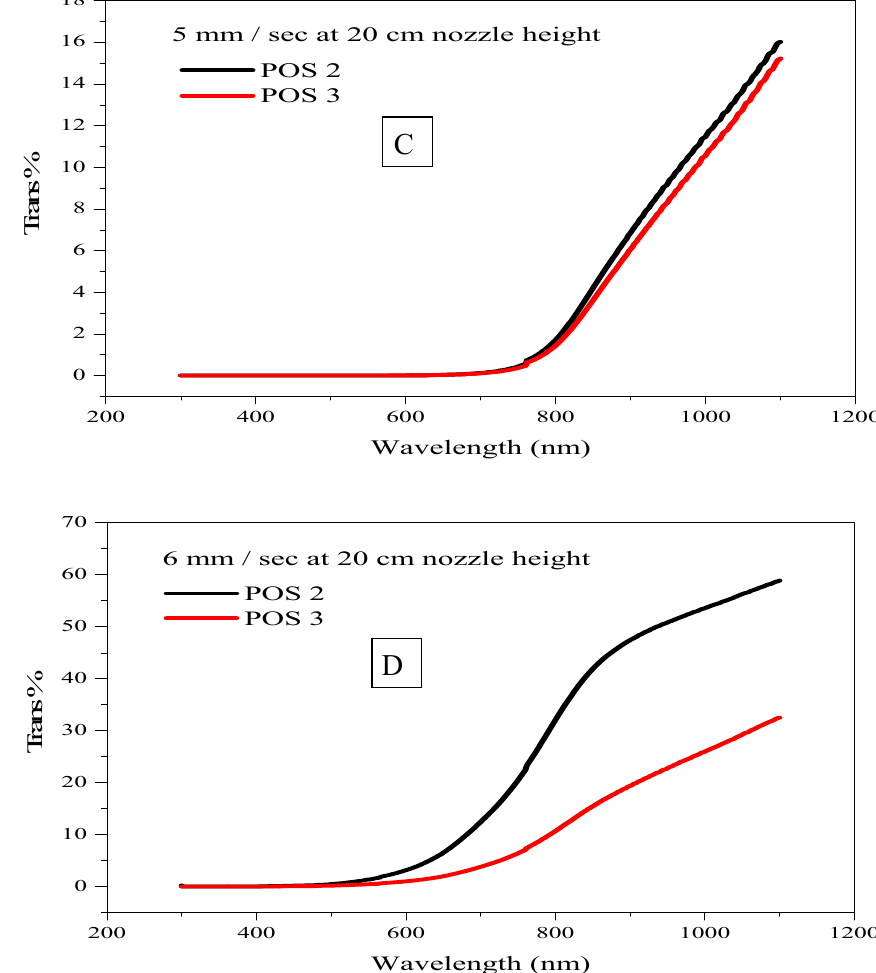
Fig. 3 (C, D): Tramsmitance spectra of CuO at different speed and postions(POS).